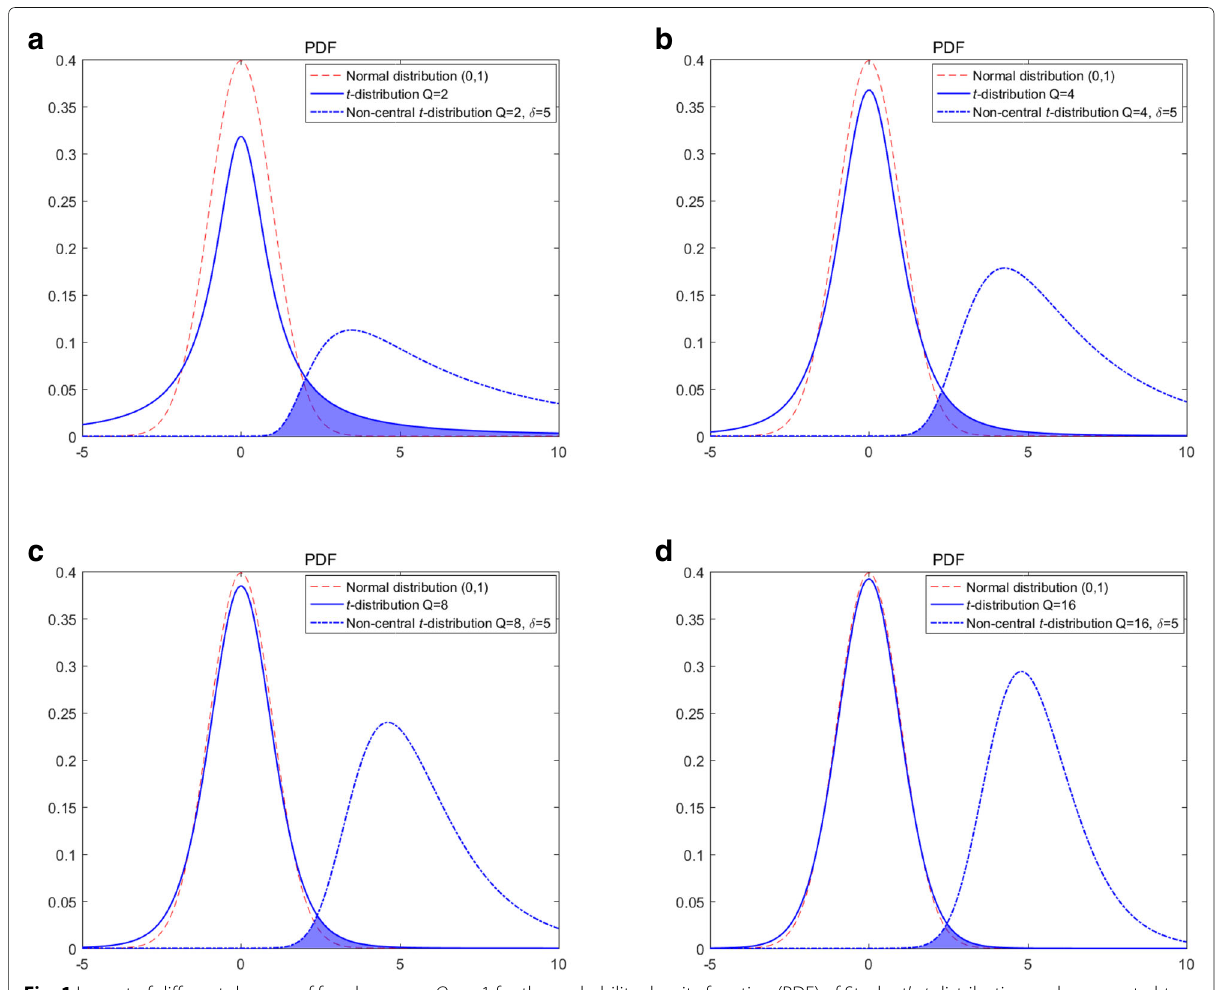
Fig. 1 Impact of different degrees of freedom v = Q − 1 for the probability density function (PDF) of Student’s t distribution and non-central t distribution. a Q = 2. b Q = 4. c Q = 8. d Q = 16